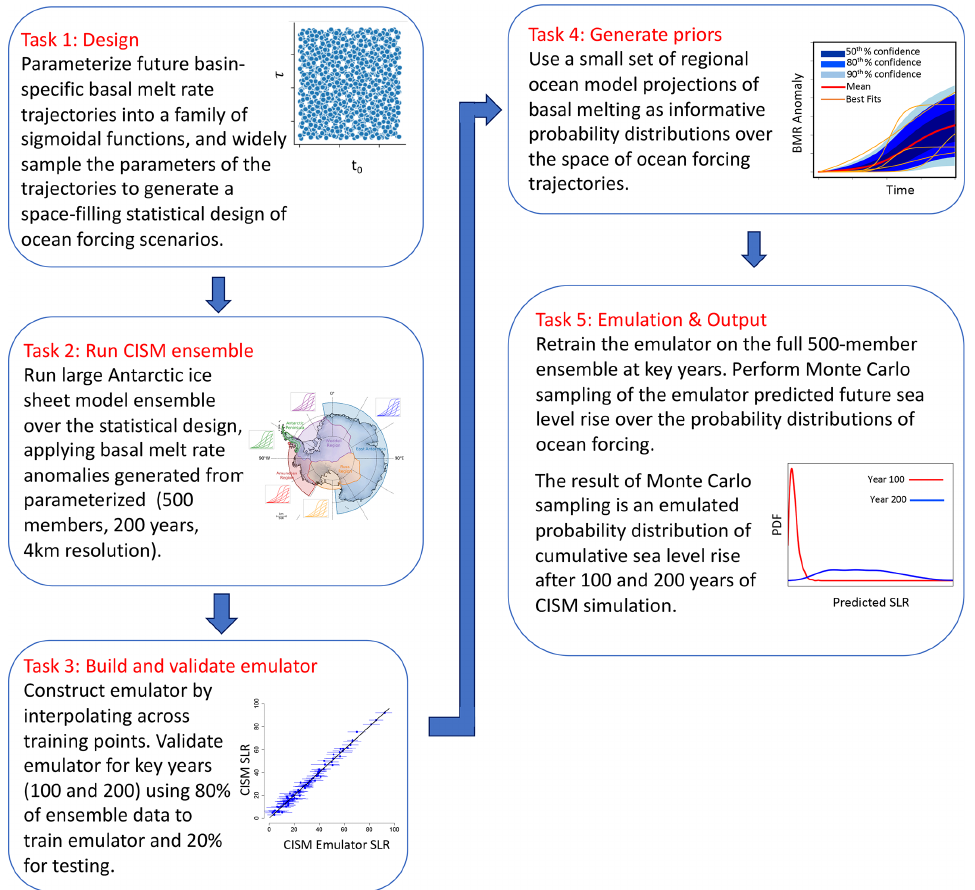
Figure 1. Schematic showing step-by-step tasks employed in this emulation study – from experimental design to probabilistic sea level rise output. Figure in Task 2 is adapted from Levermann et al.